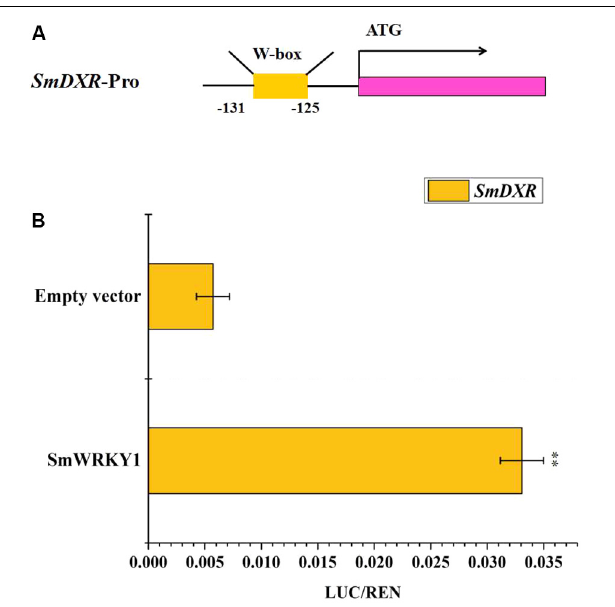
FIGURE 7 | The SmDXR promoter was fused to the luciferase (LUC) reporter and the promoter activity was determined by a transient dual-LUC assay in tobacco. The value of LUC activity/Renilla (REN) luciferase was regarded as the activating activity. Error bars indicate SD ( n = 3). Student’s t -test: